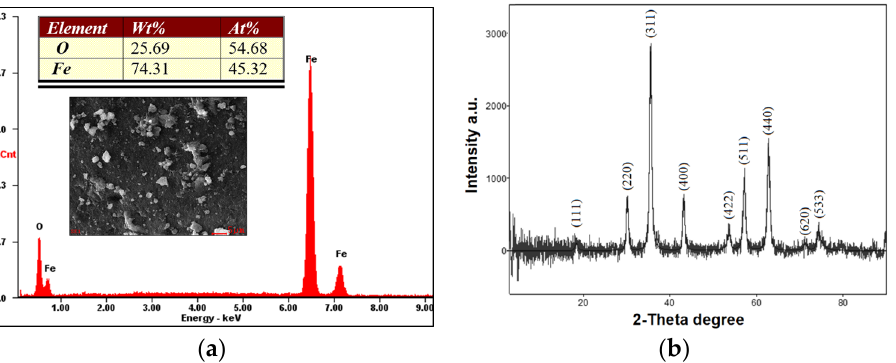
Figure 3. ( a ) EDS spectrum and elemental composition, ( b ) X ‐ ray diffraction pattern of magnetite nanoparticles.